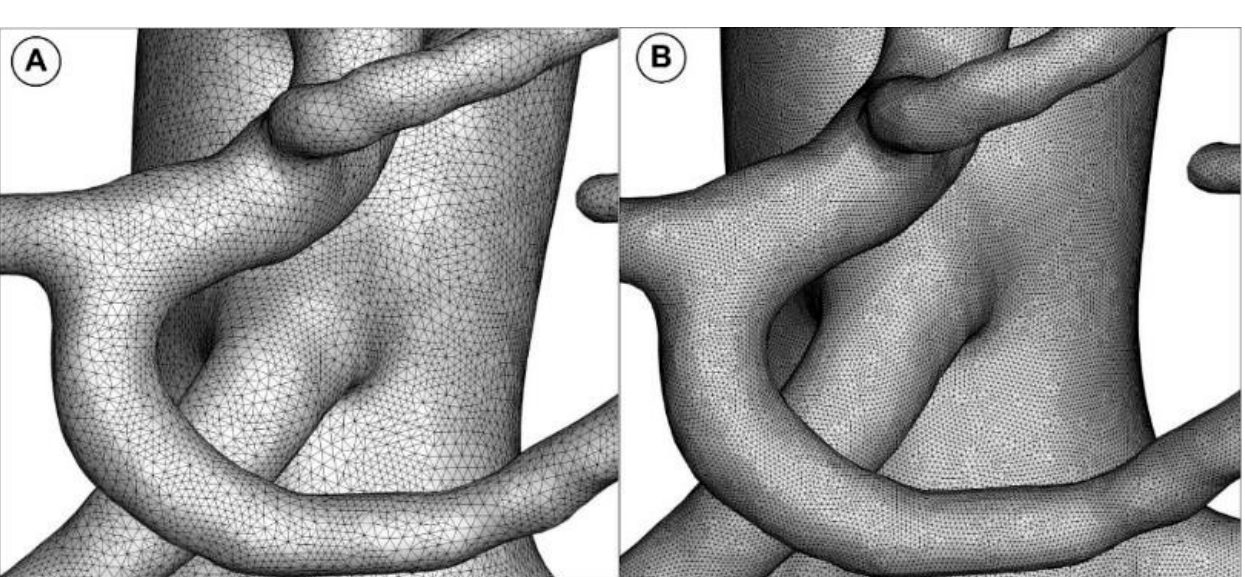
Figure 3. Abdominal aorta branching arteries’ diameter measurements during image acquisition.